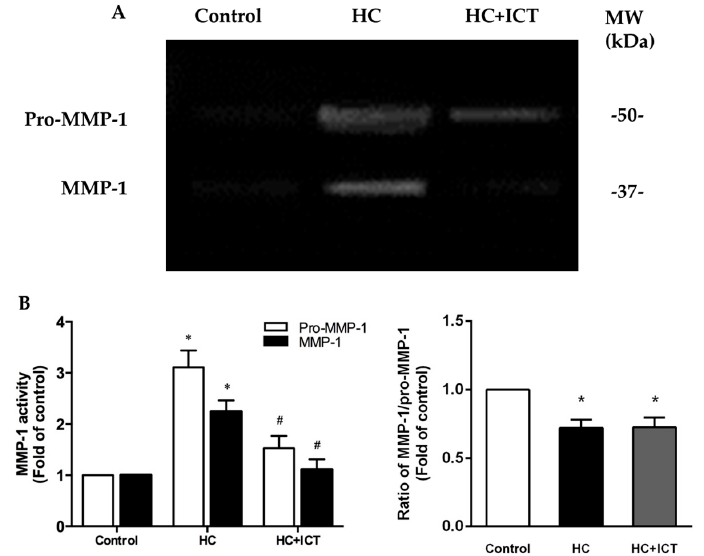
Figure 7. ICT suppressed the proteolytic activity of MMP-1 in aorta homogenates. ( A ) Representative images of gelatin zymography for pro-MMP-1 and MMP-1 activity. Cleared areas indicated proteolysis of the gelatin. MW: molecular weight; ( B ) Intensity of cleared areas corresponding to pro-MMP-1 and MMP-1, as well as the ratio of MMP-1/pro-MMP-1, were normalized to the control group and reported as the fold of the control group. * p < 0.05, between control and HC groups; # p < 0.05, between HC and HC + ICT groups. n = 5. Data were means ± SEM.